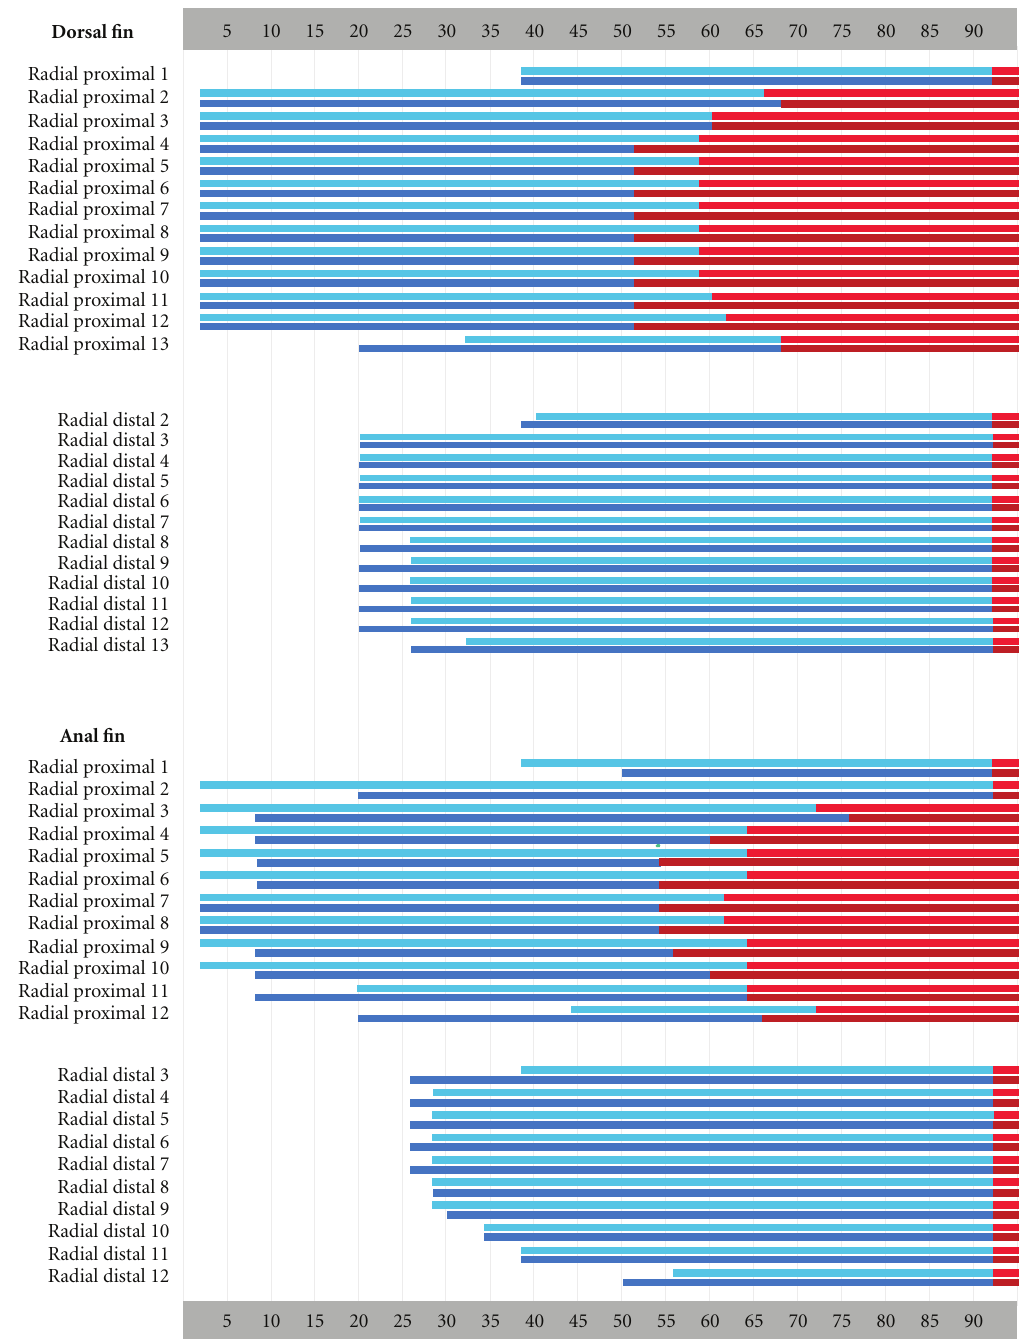
Figure 2: Sequence of chondrification and ossification for the elements of the dorsal and anal fins of Salvelinus alpinus reared in treatment S (slow; upper bars) and treatment F (fast; lower darker bars) between dph 2 and 90. Blue is for cartilage, and red is for